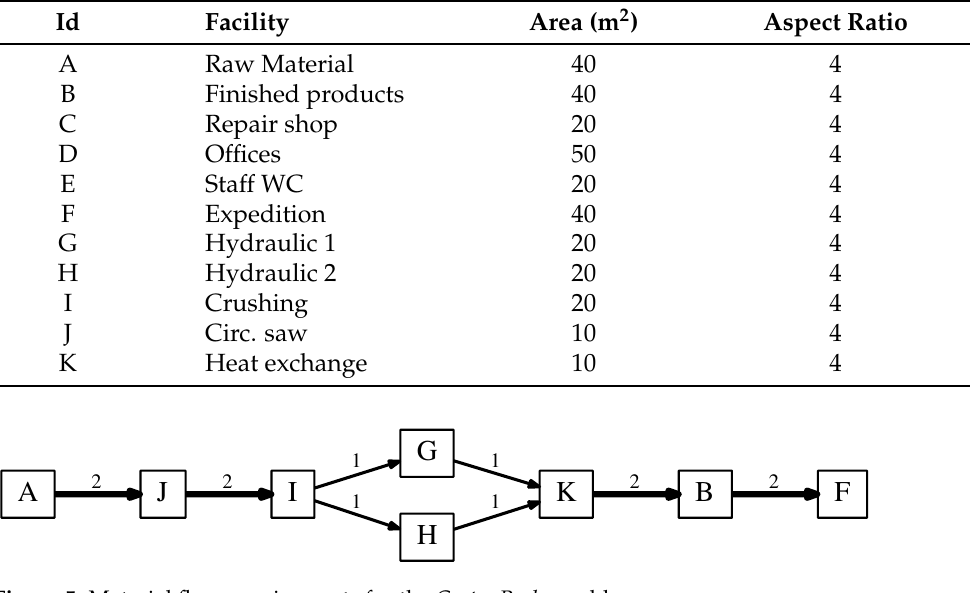
Table 4. Facility features for the CartonPacks problem.